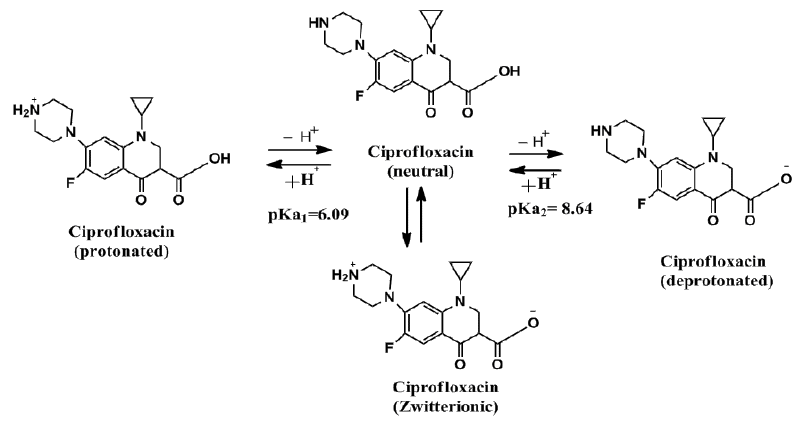
Figure 9. Forms of ciprofloxacin at different pH.